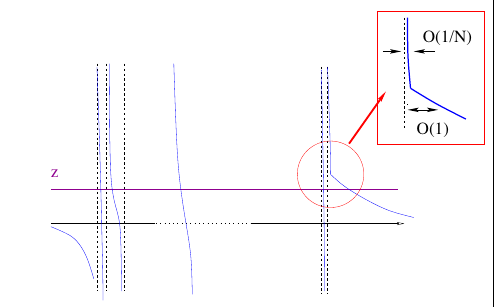
Figure 1: The dispersion relation and the mechanism of freezing: in the large N limit the curve has, to the right of the last pole, a jump in the